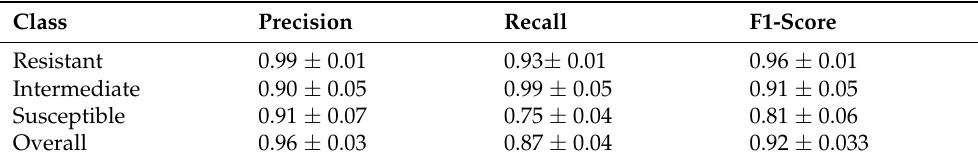
Table 5. Performance (Mean ± SD) during testing using DeepARRNet model trained with the original pea root and GAN-augmented data.